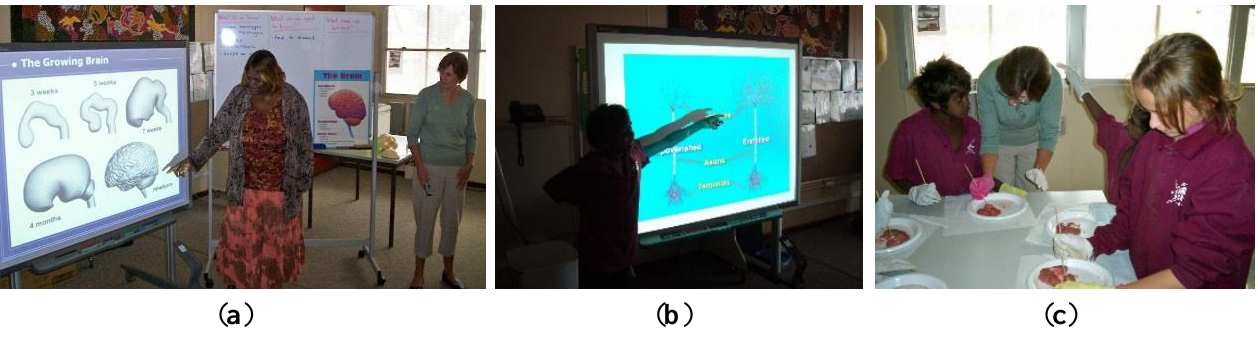
Figure 6. A local community member translating. ( a ): Science: A student explaining; ( b ) Science: Dissecting sheep brains. The anatomy of the brain into the local dialect. ( c ) The anatomy of